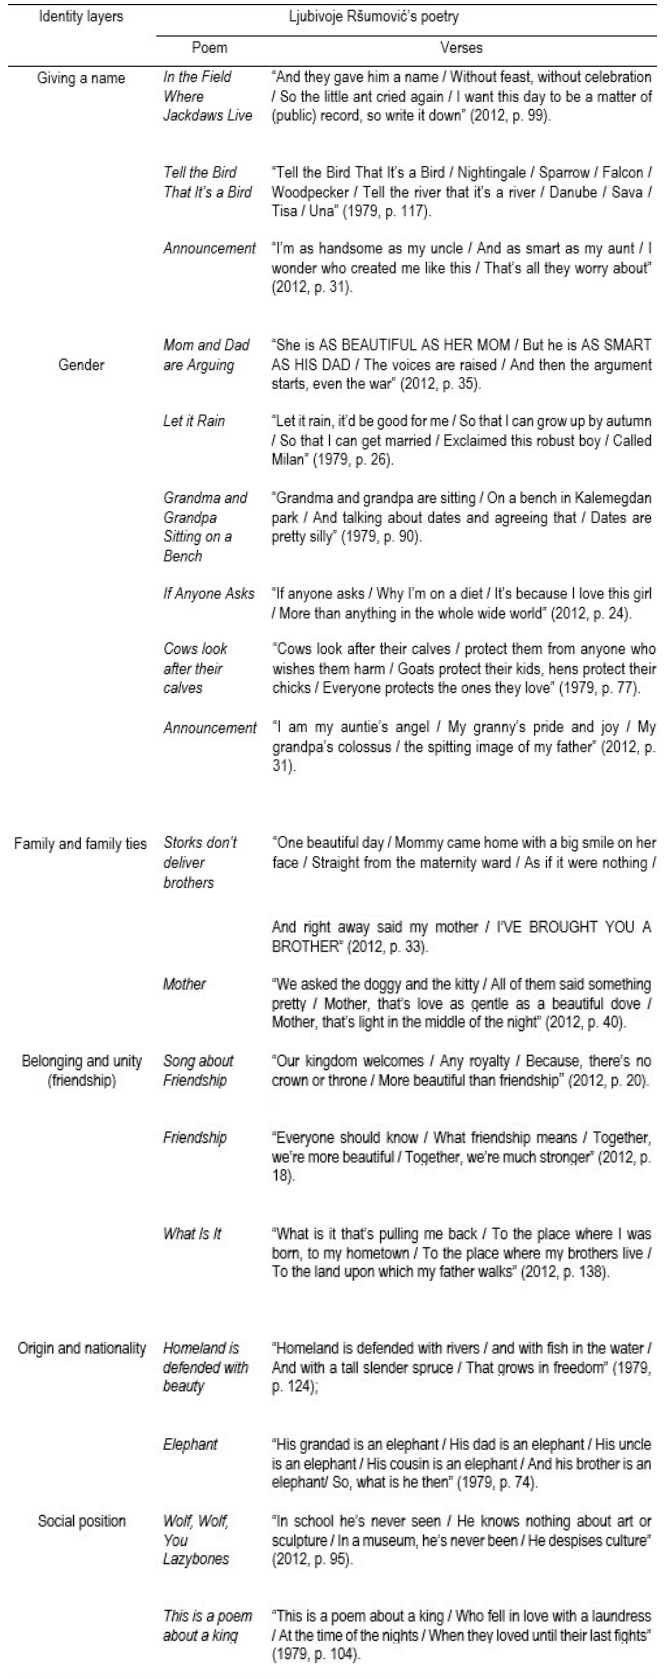
Semantic potentials of Ljubivoje Ršumović’s poetry as motivators for learning about